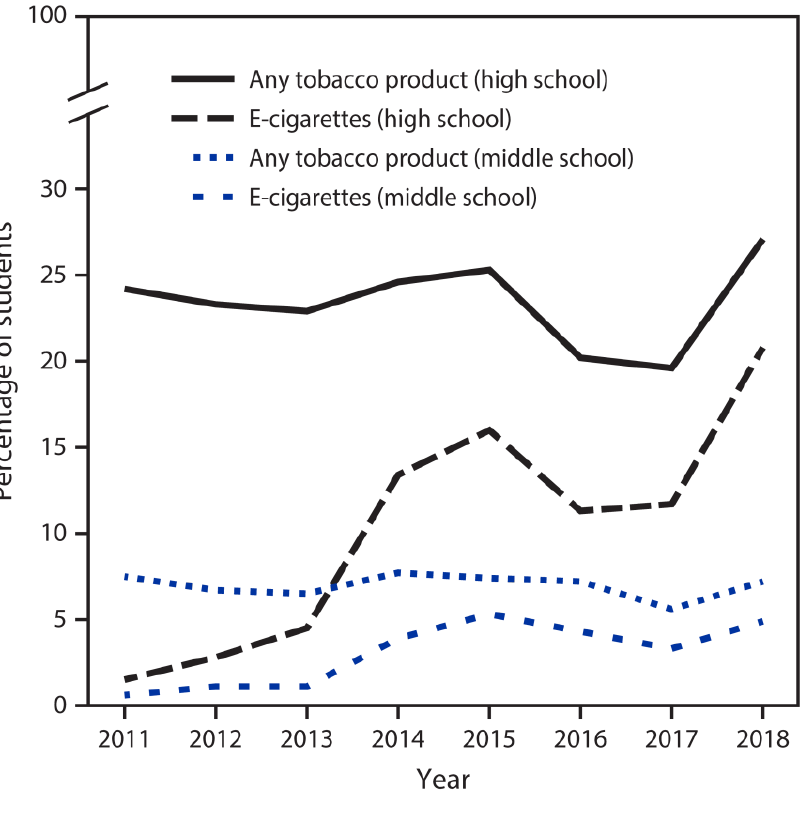
Figure 1. Percentage of middle and high school students who currently use e-cigarettes and any tobacco product---National Youth Tobacco Survey, United States, 2011-2018. Source: Cullen et al., MMWR,